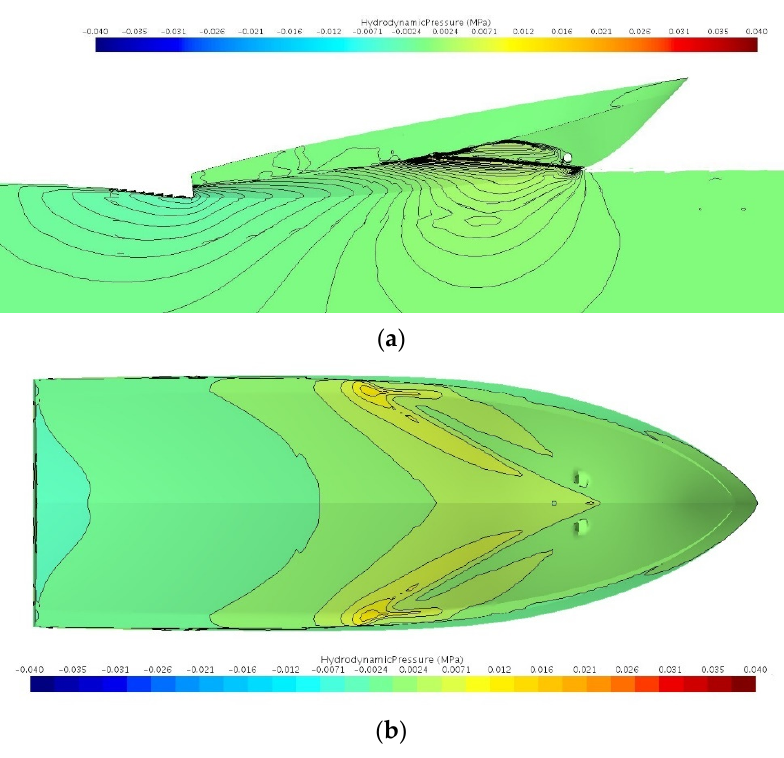
Figure 10. ( a ) Dynamic pressure field around the hull without interceptors, longitudinal view. ( b ) Dynamic pressure field around the hull without interceptors, bottom view.